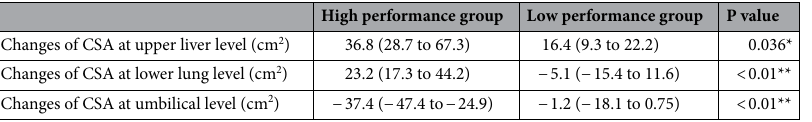
Gliding distance